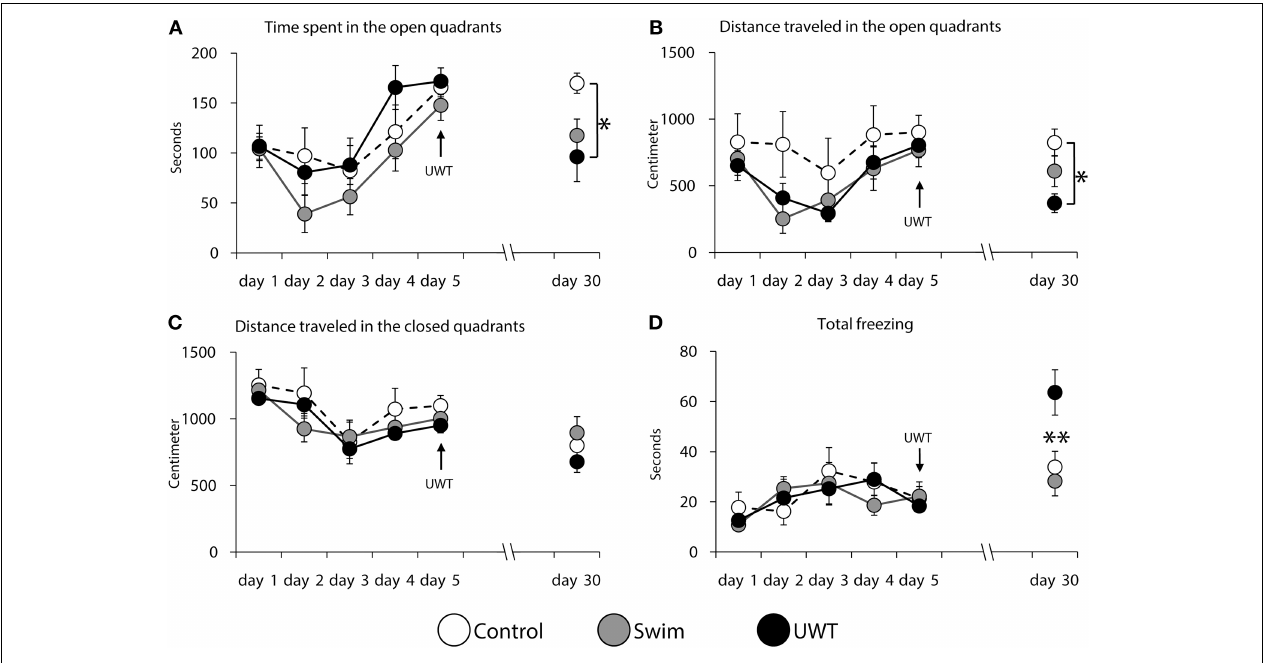
FIGURE 3 | Rats behavior during the contextual exposure to the significant difference was found in the distance traveled in the WAZM on the 30th day. Rats that were exposed to the closed quadrants of the maze between the groups (C) . Significant underwater stress spent significantly less time (A) and traveled difference was found in total time of freezing in the maze (D) . ∗ p < 0 . 05; ∗∗ p < 0 . 01. shorter distance (B) in the open quadrants of the WAZM. No Table 1 | Rats behavior before and after a stressful or traumatic experience. Control Swim